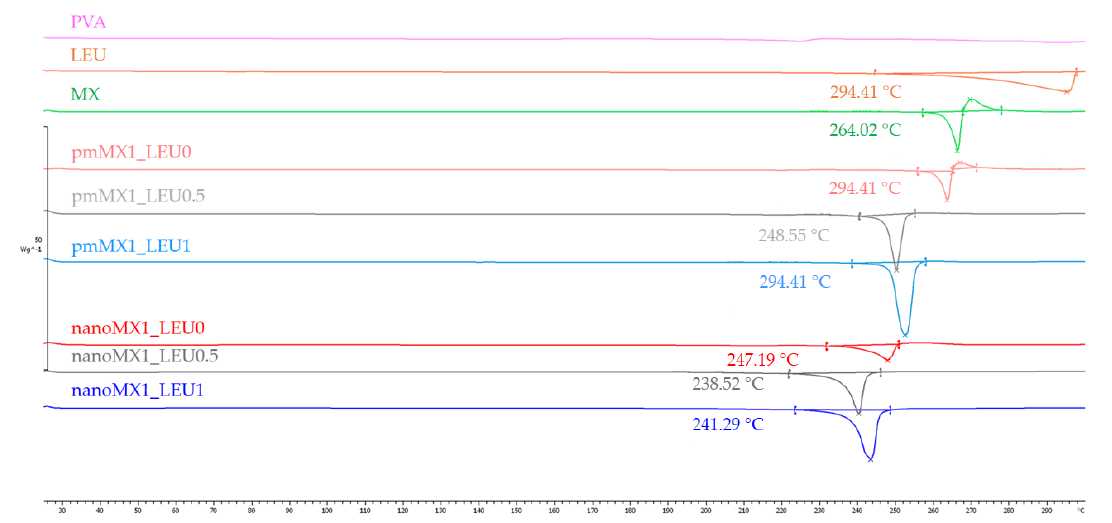
Figure 3. DSC results of the raw materials, (PVA, LEU, and MX), the physical mixtures (pmMX1_LEU0, pmMX1_LEU0.5, and pmMX1_LEU1), and the spray-dried samples (nanoMX1_LEU0, nanoMX1_LEU0.5, and nanoMX1_LEU1).